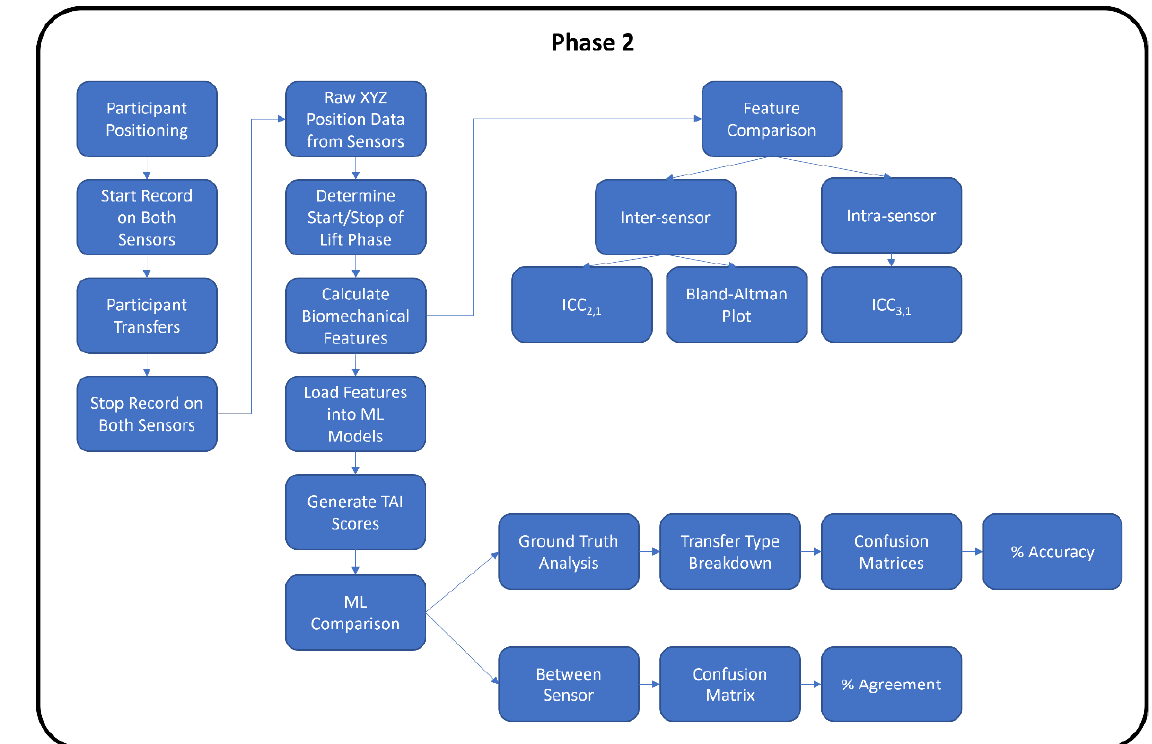
Figure 1. Experimental study flowchart for Phase 1 and Phase 2.